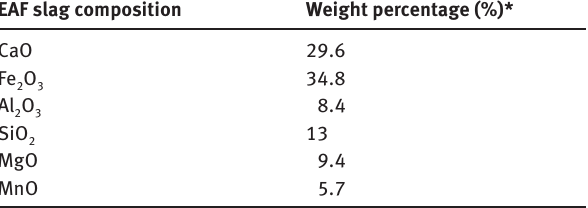
Table 3: The chemical composition of the EAF slag (wt.